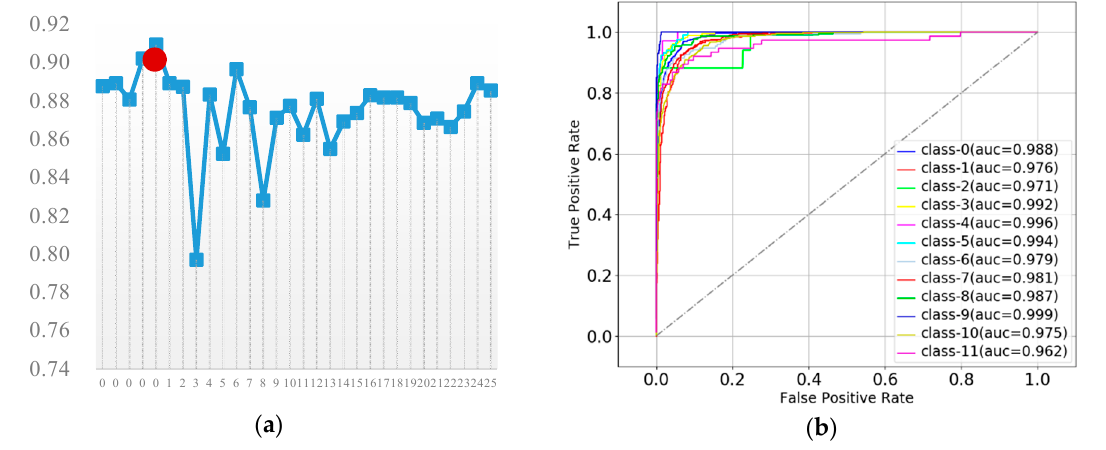
Figure 12. Parameter Tuning Process and ROC of Random Forest (RF), where ( a ) Description of the parameter tuning process of RF, where y -axis is ACC and x -axis is iteration; ( b ) ROC of RF. Table 11. Parameter Tuning Process of Random Forest Classifier.